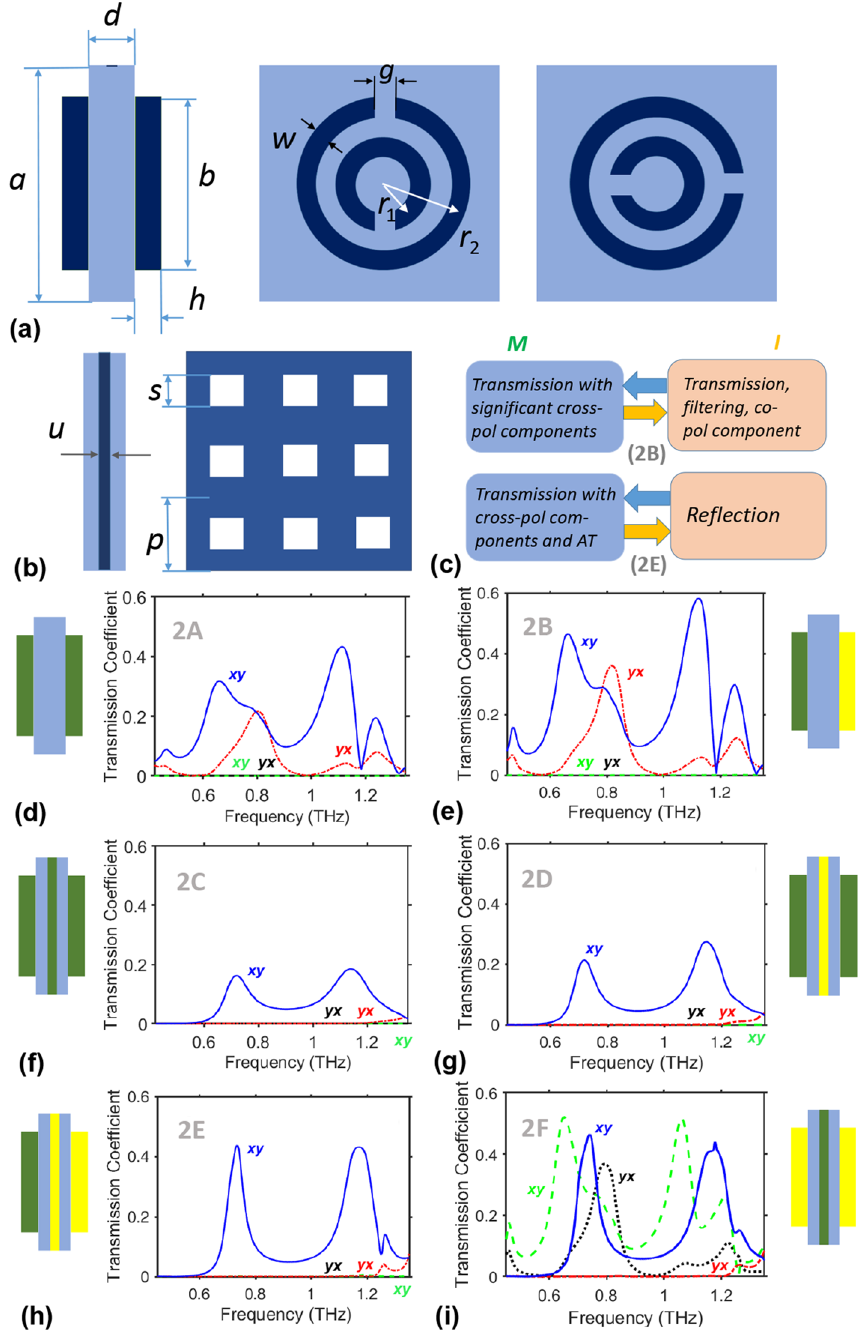
Figure 3. ( a ) From left to right: side cross-section view of a unit cell of metasurface 2A, 2B with a dielectric spacer, and front and back views of a unit cell of metasurfaces 2A–2F. Dark blue and light blue colors correspond here to DSRs and spacers, respectively. The DSR on the front face is made of VO 2 (2A–2E) or Cu (2F), and the DSR on the back face is made of VO 2 (2A, 2C, 2D) or Cu (2B, 2E, 2F). ( b ) Side cross-section and mid-cross- section views of the spacer of thickness d , which comprises either a Cu grid (2D, 2E) or a VO 2 grid (2C, 2F) in the middle. ( c ) Examples of the functionality switching vs. VO 2 phase for metasurfaces 2B and 2E. | τ Q nm | vs. f is plotted for metasurfaces ( d ) 2A, ( e ) 2B, ( f ) 2C, ( g ) 2D, ( h ) 2E, and ( i ) 2F, at a = 210 µ m , d = 19.69 µ m , h = 8.75 µ m , r 1 = 44.63 µ m , r 2 = 72.63 µ m , w = 12.25 µ m , g = 14 µ m , p = 70 µ m , s = 35 µ m , u = 3.94 µ m . Key: | (solid blue curves), | τ M → | (dash-dotted red curves), | τ I → | (dashed green | = | τ M ← | = | τ M ← | = | τ I ← | τ M → yx xy yx xy yx xy curves), and | τ I → yx | = | τ I ← xy | (dotted black curves); | τ I → xy | ≈ 0 and | τ I → yx | ≈ 0 in ( d – h ). Labels xy and yx are shown near and by the same color as the corresponding curve(s) that are the subscripts of τ → . The insets in ( d – i ) present schematics of composition of a unit cell of the metasurface, in accordance with ( a , b ); dark green and yellow colors stand for VO 2 and Cu components, respectively, and blue color stands for the teflon